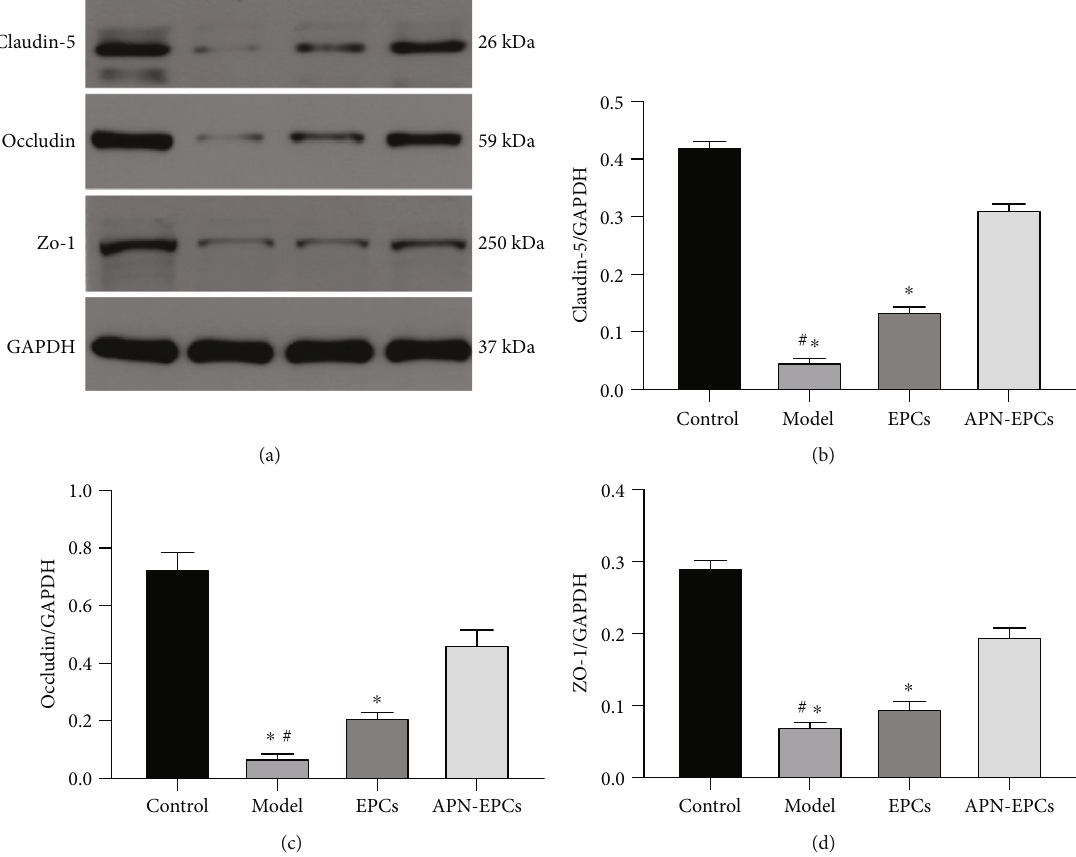
Figure 6: In fl uence of APN-EPC treatment on BBB function. (a). Western blotting results of the BBB-related proteins. (b). Quantitative result of claudin-5. (c). Quantitative result of occludin. (d). Quantitative result of Zo-1. ∗ p < 0 : 05 the model group or the EPC group compared with the APN-EPC group, # p < 0 : 05 the model group compare with the control